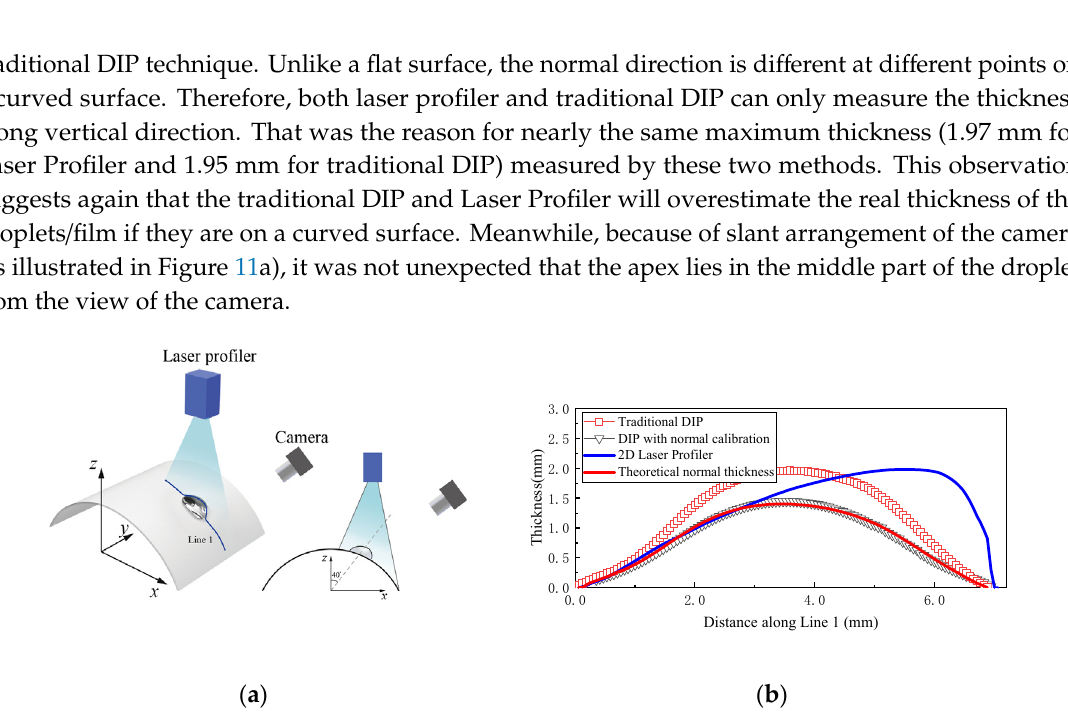
Figure 11. Measurement results of a droplet on the cylindrical surface: ( a ) sketch of the experimental setup; ( b ) thickness along Line 1.